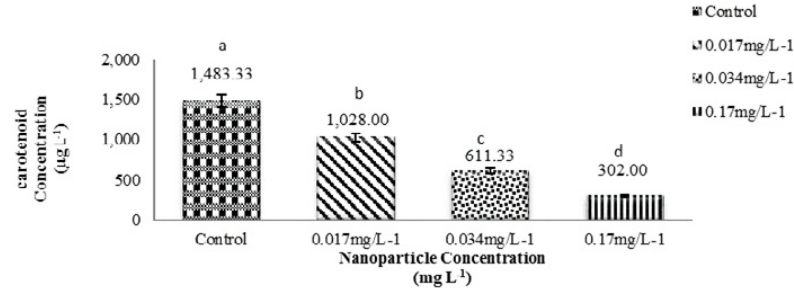
Fig. 5. Mean carotenoid level at different concentrations of SiO 2 NPs. Notes: Treatments with at least one commonality are statistically significant ( p <0.05).